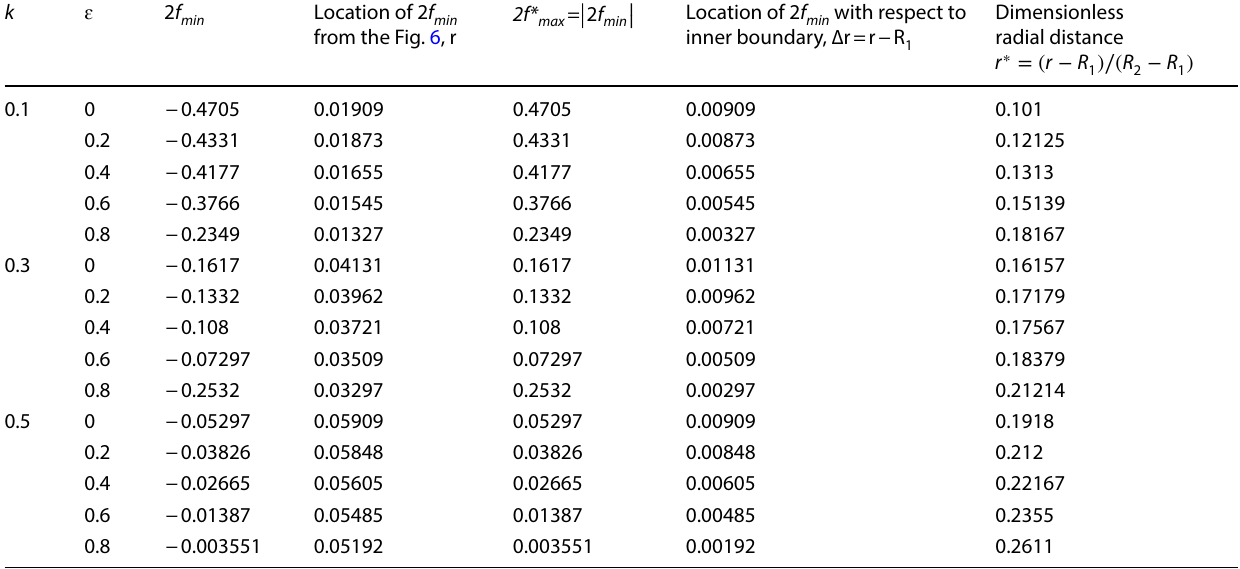
Table 4 Peak values of 2 f , calculated for specified plane P